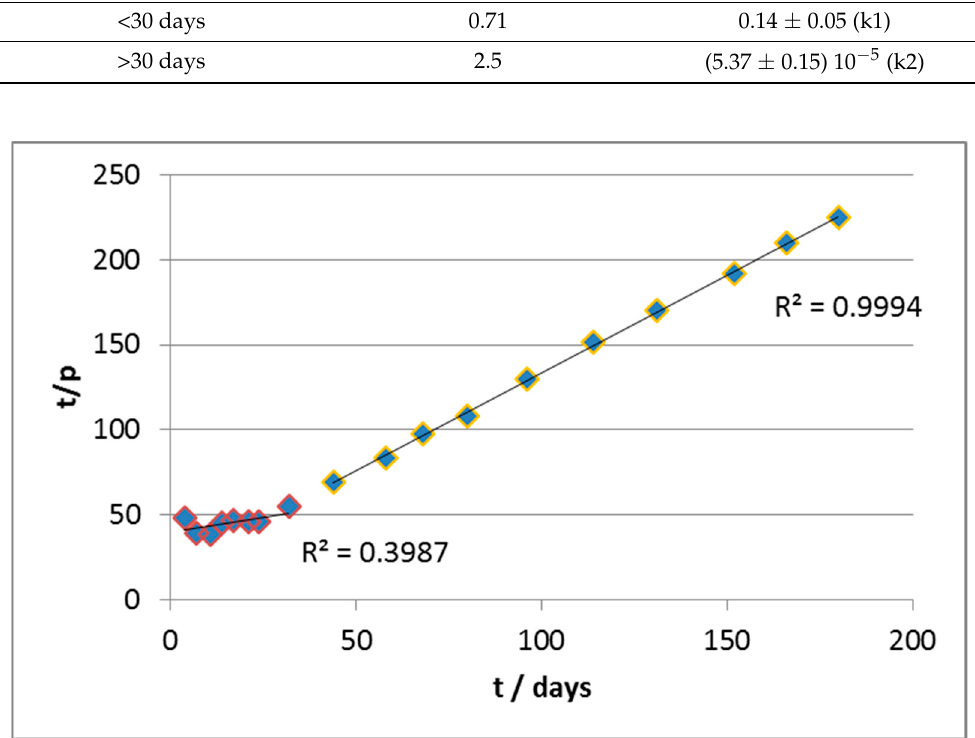
Table 2. Kinetic parameters for the Wilkinson Model used to interpret the biodegradation of formulate B.